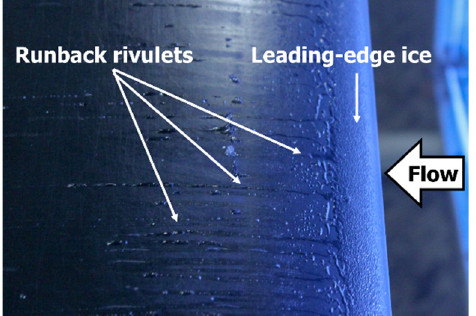
Figure 8. De-icing test, moments before the ice shedding. Liquid water is produced from the leading-edge and refreezes downstream.